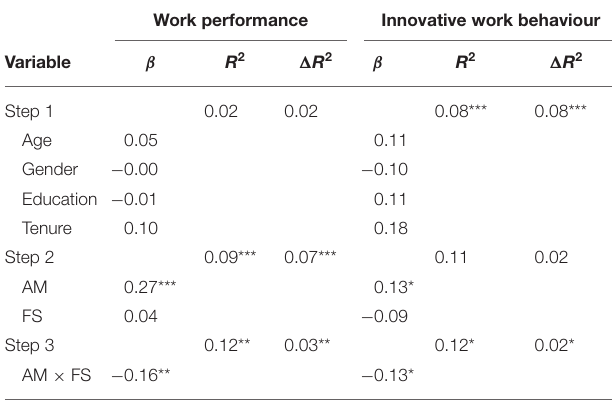
TABLE 1 | Means, standard deviations, correlations, and Cronbach’s α for the main study variables. Variables